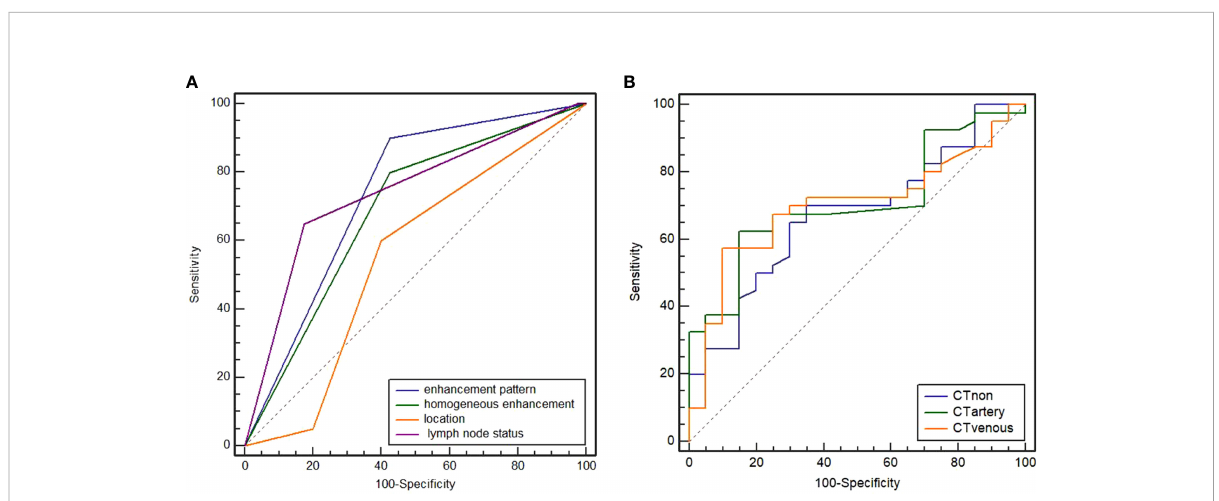
FIGURE 1 Receiver operating characteristic (ROC) curves of enhancement pattern, homogeneous enhancement, CT-de fi ned lymph node status, and location (A) . The areas under curve (AUC) were 0.716, 0.645, 0.738, and 0.543, respectively. ROC curves of attenuation in non-contrast, arterial, and venous phases (B) . The AUC were 0.673, 0.709, and 0.699,